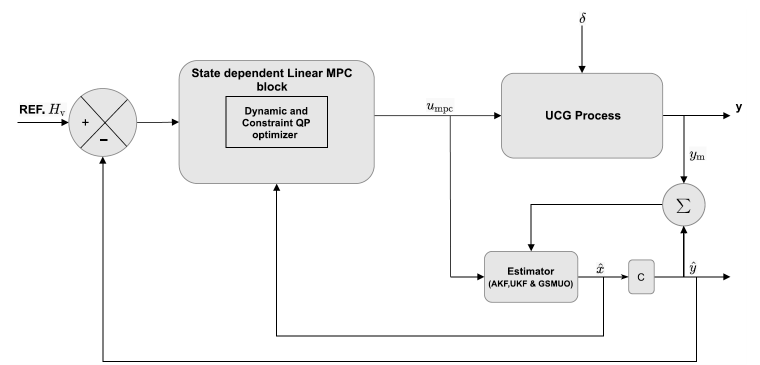
Figure 31. Scheme of MPC implementation for UCG